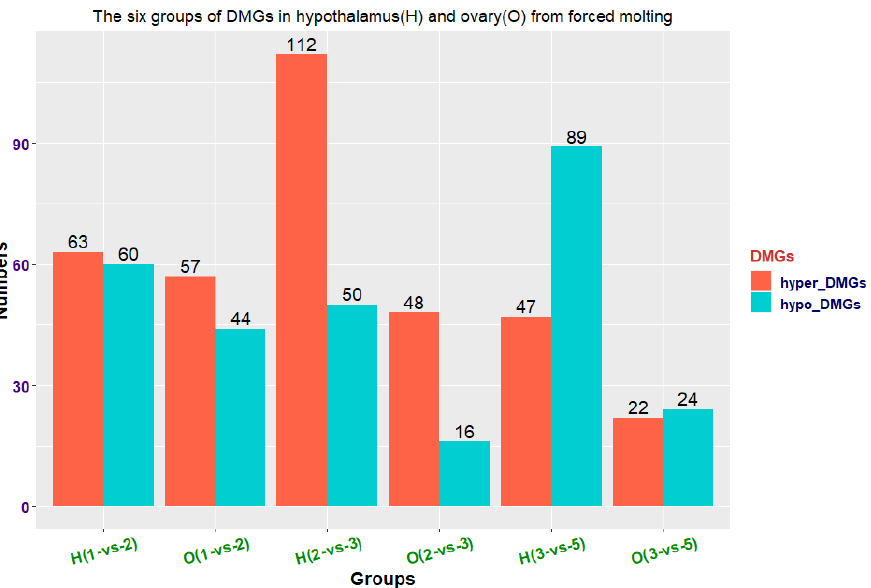
Figure 3. Number of hyper and hypo DMRs in each group and the corresponding number of DMGs. Table 1. DMGs in two reversible processes during FM in the hypothalamus and ovary. Tissue